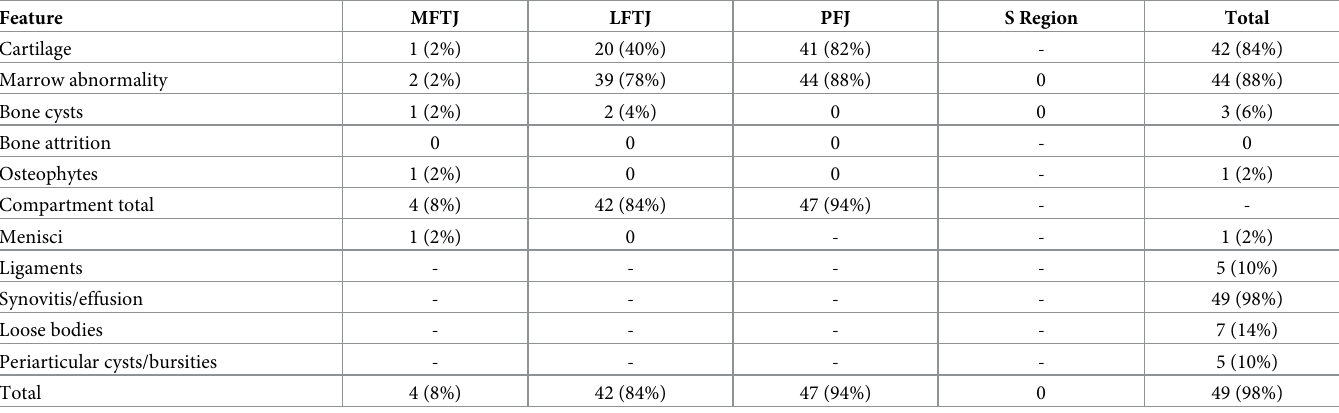
Table 2. Number of patients with abnormalities of the knee joint according to WORMS.